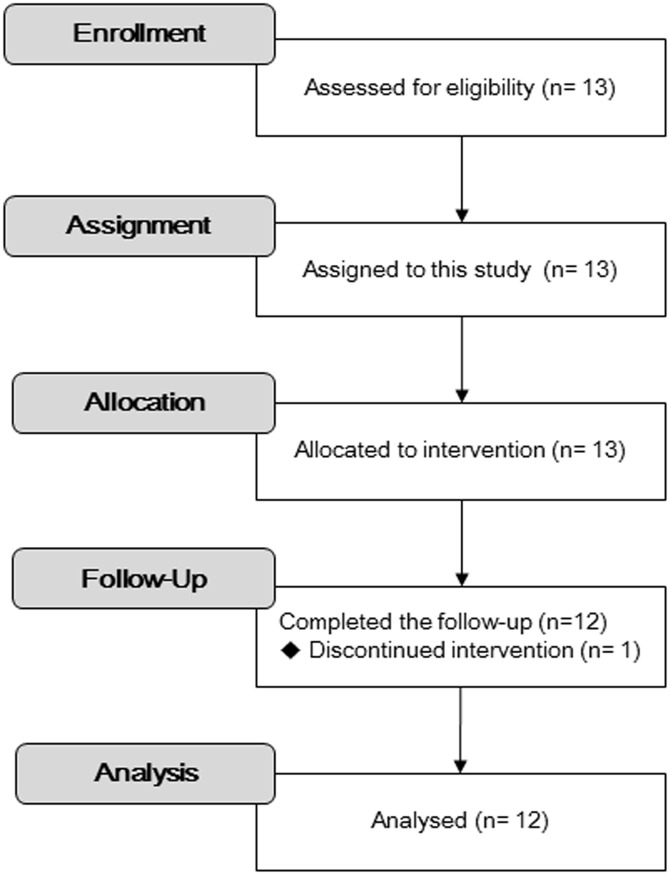
Consort flow chart.